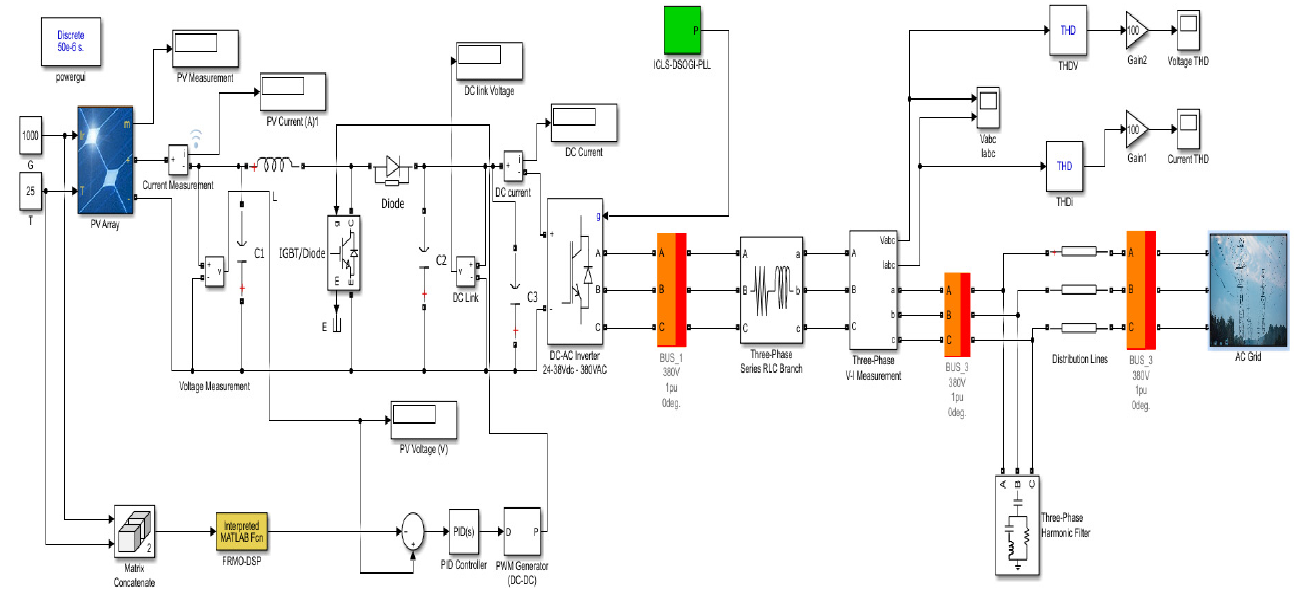
16 of 32 Figure 6. Flow chart of PWM subroutine. 5. System Setup Three case studies were undertaken to assure the genuine performance of the pro-